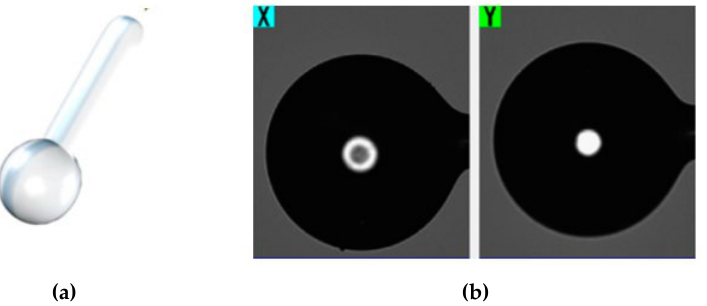
Figure 7. Image of the ball resonator: ( a ) 3D picture of optical ball resonator; ( b ) photographs taken by X and Y cameras of CO 2 laser splicer. Image reproduced from [57].